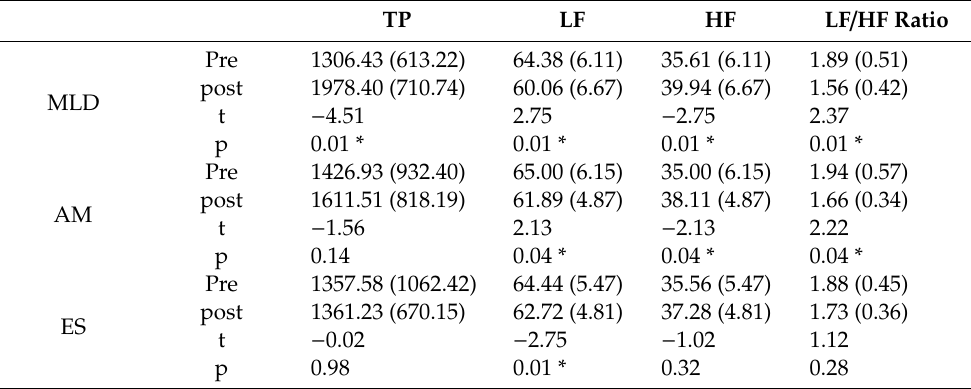
Table 3. Autonomic nervous system t -test (n = 54).